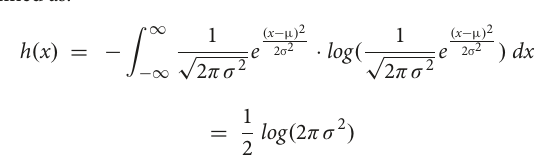
rejected, as well as trials of EOG V p − p larger than 1 mV. Trials with channels that had less than 0.1 µ V as a minimum signal V p − p were considered flat and rejected. No recording presented more than 10% of trial